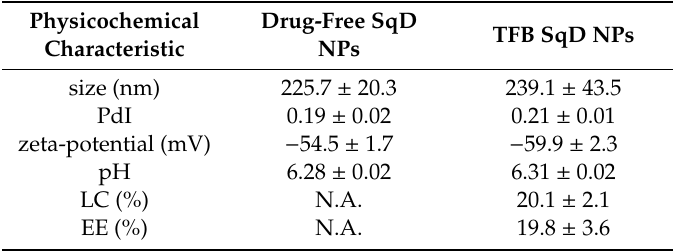
Table 3. Physicochemical characteristics, including size, polydispersity index (PdI), zeta-potential, pH, loading capacity (LC) and encapsulation e ffi ciency (EE), of SqD nanoparticles (NPs) determined by dynamic light scattering (DLS), electrophoretic light scattering (ELS), pH measurements, and HPLC. Results are reported as mean ±